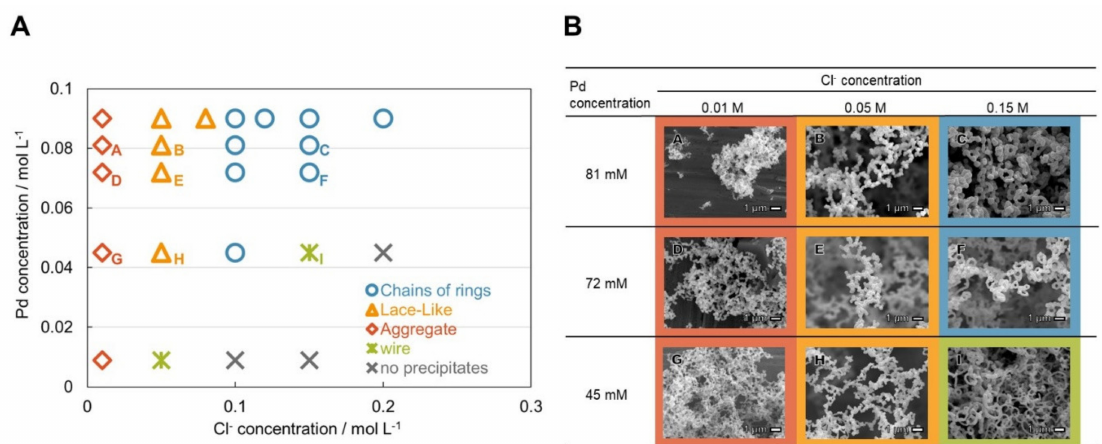
Figure 5. Shape control of the nanostructure by Pd and Cl concentration. ( A ) Diagram of nanostructure shapes as function of Pd and Cl concentrations. ( B ) SEM images of precipitates formed at various Pd and Cl concentrations. Pd particles produced a lacelike 3D network (B, E, H) at a Cl concentration of 0.05 M, and produced chains of nanoring structures and nanowires (C, F, I) at a Cl concentration of 0.15 M. The size of the nanoparticles and thickness of the rings decreased as the Pd concentration